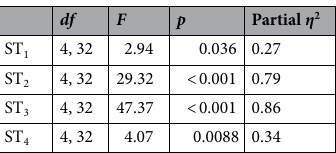
Table 3. One-way repeated-measures ANOVA tables for the effect of gravity levels on the task-dependent variables, t , of ST